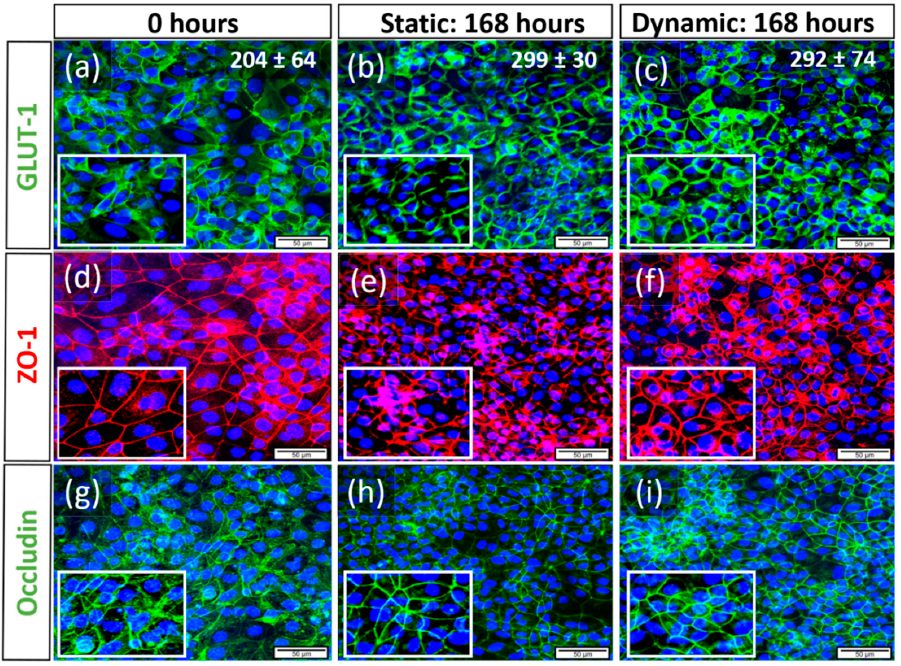
Figure 7. Changes of cell morphology and protein expression of hiPSC-derived BCECs compared between dynamic and static culture conditions, representative images of N = 3 biological replicates, scale bar = 50 µM, magnification = 40×. Via immunofluorescence, the expression of the Glucose transporter-1 (GLUT-1, ( a – c )), as well as the TJ proteins Zonula Occludens-1 (ZO-1, ( d – f )) and Occludin ( g – i ), was observed. In both 168 h static and dynamic conditions, BCECs showed more nuclear compaction and increased expression of relevant proteins such as GLUT-1 ( b , c ), ZO-1 ( e,f ), and Occludin ( h , i ), respectively, when compared to 0 h static conditions ( a,d,g ). Zoomed in frames show more cytoplasmic localization of GLUT-1 ( a ) at day 0 when compared to 168 h dynamic conditions ( c ). In all markers, we observed more pronounced protein localization at the cellular borders post-168 h of static (zoomed in frame ( b , e , h )) and dynamic conditions ( c , f , i ). However, BCECs cultivated under 168 h of flow showed more continuous and smooth membranous staining patterns, while BCECs of long-term static culture represented discontinuous staining patterns. The cell numbers counted for each culture condition are inserted in the upper right corner of the respective images ( a – c ).